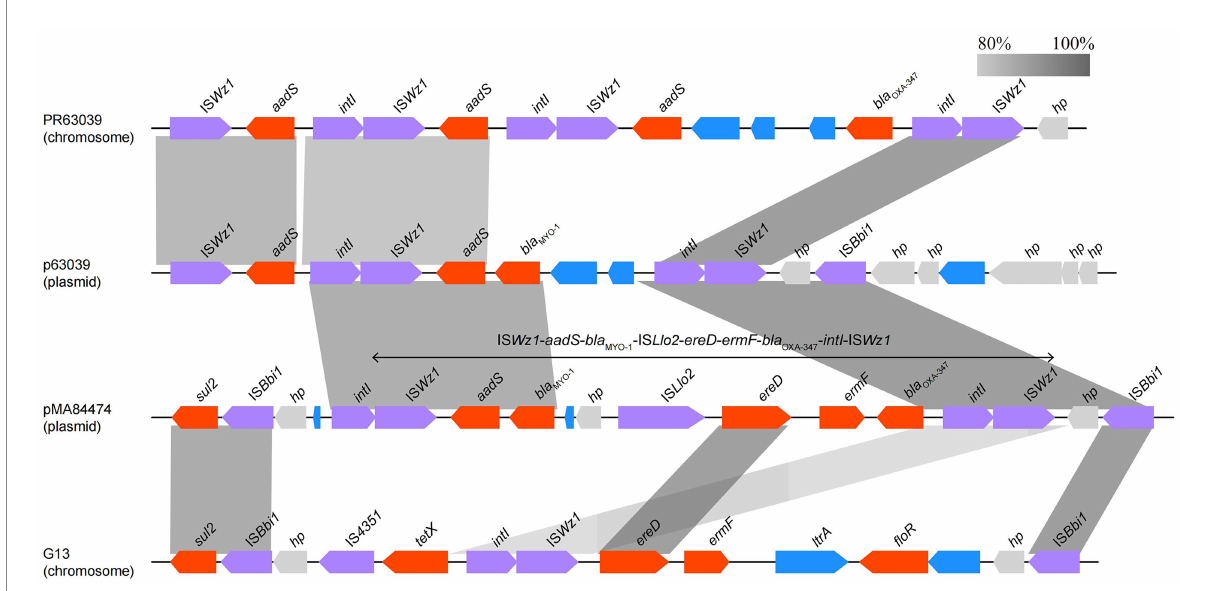
FIGURE 5 Comparison of the MDR region of pMA84474 with the related sequences. Genes are denoted by arrows and colored according to gene function classification. Shading indicates the homologous regions. The sequences and accession numbers are Myroides odoratimimus PR63039 chromosome (NZ_CP013690.1), Myroides odoratimimus p63039 plasmid (NZ_CP013691.1), and Myroides odoratimimus G13 chromosome (NZ_